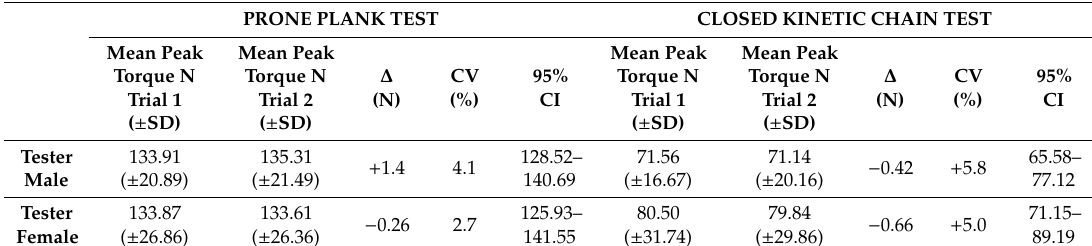
Table 1. Descriptive data PPT and CCC test (T1). N = Newton; Δ = mean difference; CV = coefficient of variation; CI = confidence intervals.